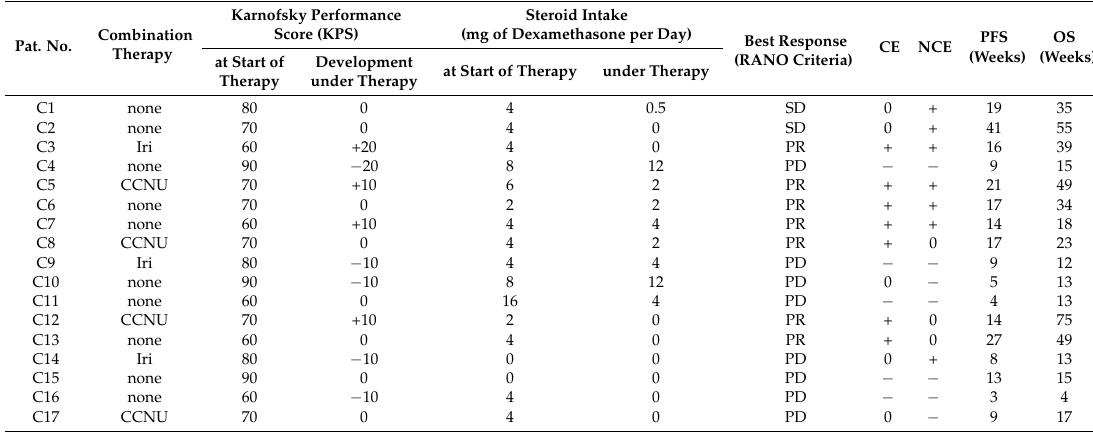
Table 2. Outcome of the patients with a non-diffuse growth